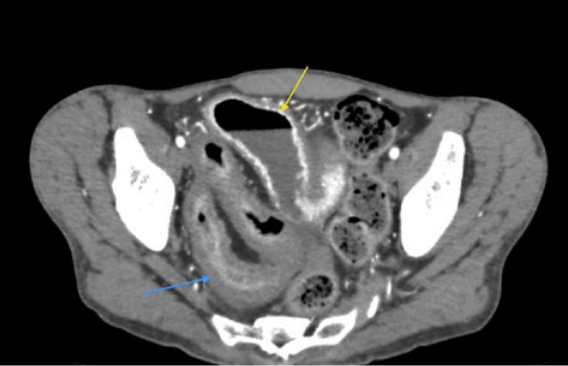
Figure 1d: Axial CT in a known patient with Crohn’s disease showing mural hyper-enhancement (yellow arrow) and mural thickening (blue